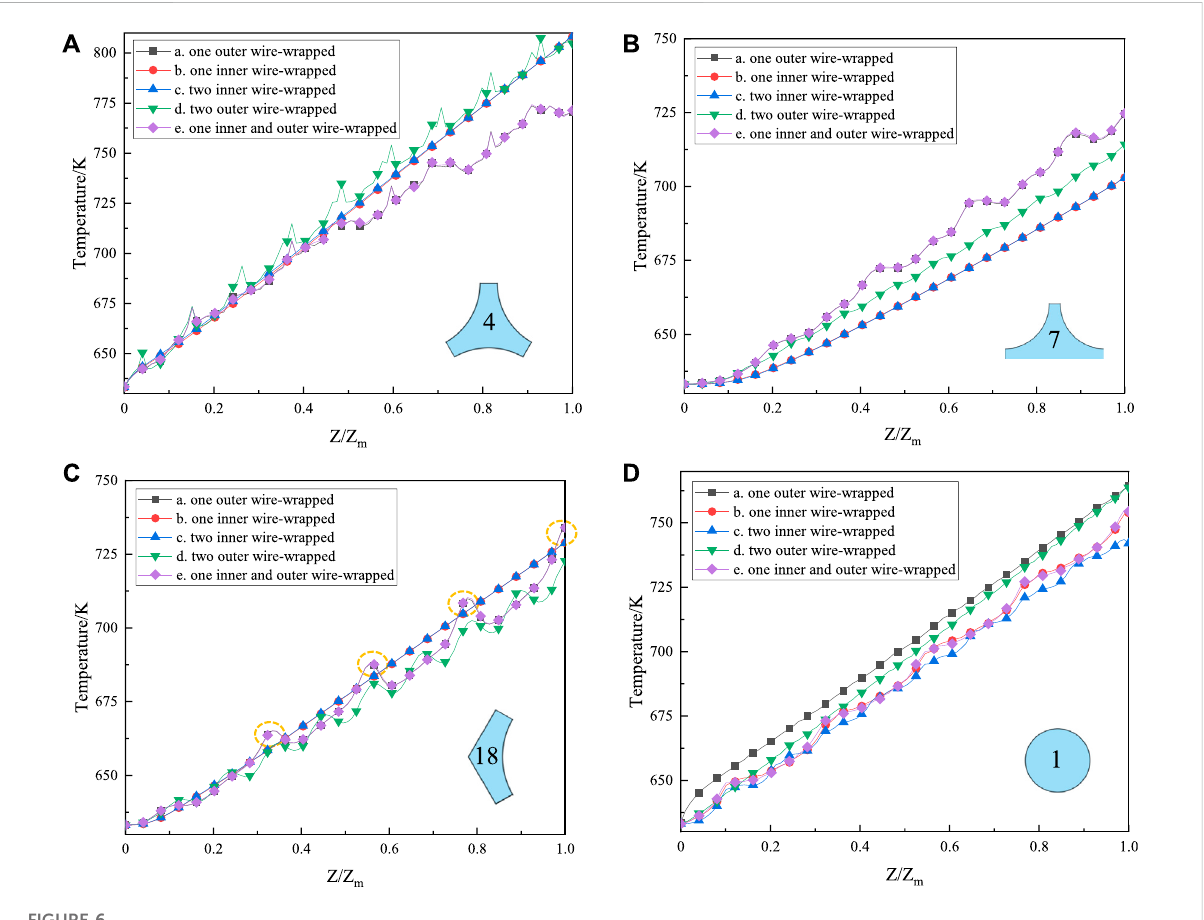
FIGURE 6 Distribution of temperature in the (A) interior sub-channel, (B) edge sub-channel, (C) corner sub-channel, and (D) inner fl ow fi eld.